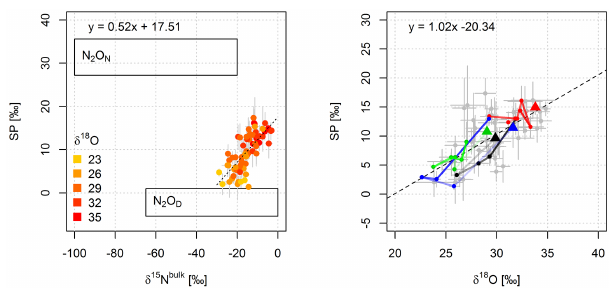
Figure 7. Left panel: map of SP vs. δ 15 N bulk , with rectangles repre- senting process groups N 2 O N and N 2 O D based on SP values in De- cock and Six (2013b), δ 15 N bulk estimated from minimum and max- imum fractionation factors reported in Baggs (2008), and substrate isotopic compositions reported by Bedard-Haughn et al. (2003), Pörtl et al. (2007) and Toyoda et al. (2011). Right panel: map of SP vs. δ 18 O with traces of management events (Mana I in black, Mana II in red, Mana III in green) and the rewetting event (blue). Isotopic compositions are plotted for the transparent blue sections in Fig. 3, including one preceding and one following composition. The preceding composition is represented by the enlarged filled triangle and transparency of the line connecting the composition decreases with event